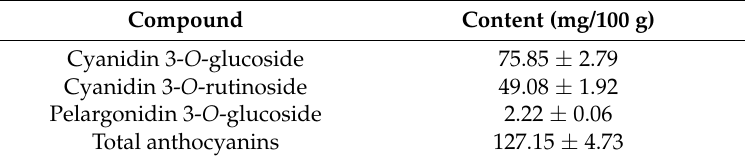
Figure 1. UPLC chromatograms of anthocyanins and flavonols in HM samples. ( a ) Anthocyanins (detected at 515 nm). ISTD, internal standard (cyanidin 3,5-diglucoside 100 ppm); Peak 1, cyanidin 3- O -glucoside ( m / z 449); Peak 2, cyanidin 3- O -rutinoside ( m / z 595); Peak 3, pelargonidin 3- O -glucoside ( m / z 443). ( b ) Flavonols (detected at 350 nm). ISTD, internal standard (galangin 20 ppm); Peak 1, quercetin 3- O -rutinoside (rutin; m / z 610); Peak 2, quercetin 3- O -glucoside (isoquercitrin; m / z 464); Peak 3, quercetin 3- O -(6”- O -malonyl)glucoside ( m / z 550); Peak 4, kaempferol 3- O -rutinoside (nicotiflorin; m / z 594); Peak 5, kaempferol 3- O -glucoside (astragalin; m/z 448); Peak 6, quercetin ( m / z 302); Peak 7, kaempferol ( m / z 286). UPLC, ultra-performance liquid chromatography; HM, high hydrostatic pressure extract of mulberry fruit. Table 1. Contents of total anthocyanins isolated from HM.